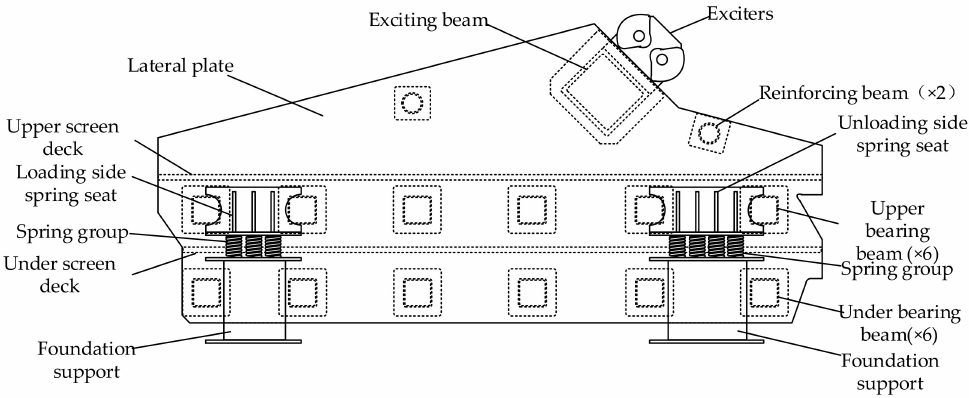
Figure 1. Structures of the SLK3661W mining vibrating screen (lateral view). The left side is the loading side and the right side is the unloading